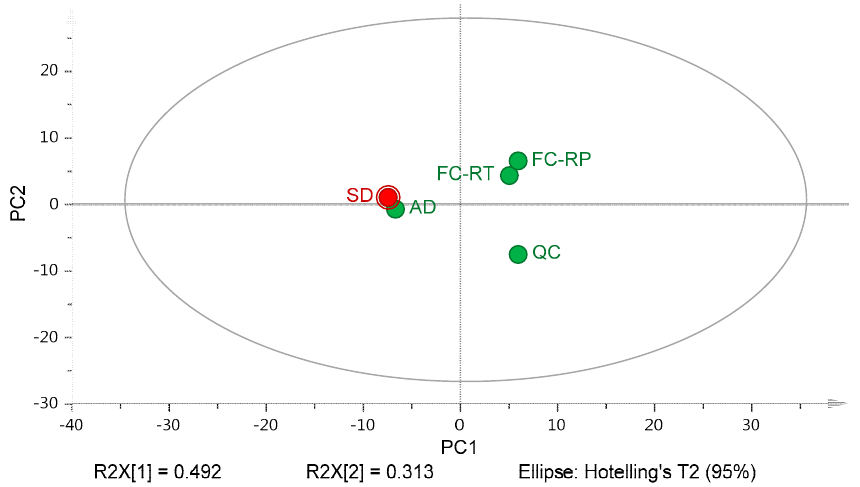
Figure 11. PCA score plot analysis of T g values and widths of glass solutions produced by film casting performed: at RT (FC-RT) and under reduced pressure (FC-RP); (QC) quench cooling, (AD) atomization screening device, and (SD) spray dryer for IBU, NAP, CAR, and ITR mixed with the set of polymers tested.